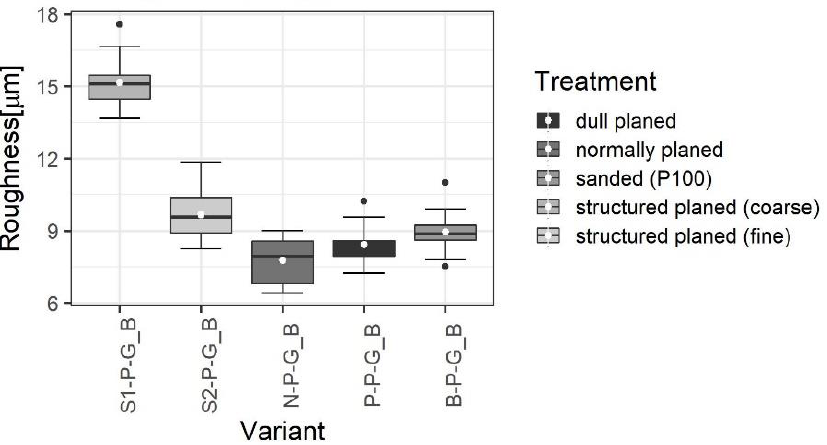
Figure 3. Roughness values of different surfacing methods are compared using boxplots. Boxplots show minimum and maximum values, the white point displays the arithmetic mean value, and the thick horizontal line represents the median. The black point stands for the outlier value.